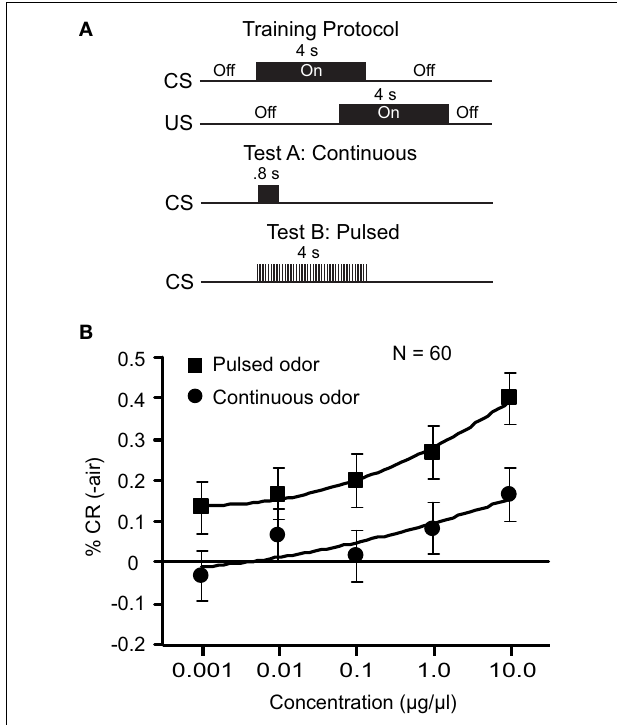
FIGURE 6 | Pulsing odor lowers detection thresholds. (A) Schematic of training and testing protocols for assessing detection thresholds. Animals were trained to respond to an odor presented continuously for 4-s using sucrose as a US. Acquisition of the CR was assessed using both test stimuli: either A on the fi rst and B on the second day or vice versa. Test A was a 0.8-s continuous odor stimulus and Test B a 4-s stimulus pulsed at 20 Hz with a 10:40 ms on:off duty cycle. Stimulus durations and duty cycles adjusted so that the total odor delivered for Test A was identical to Test B. (B) Mean conditioned response as a function of concentration of pulsed stimulation (squares) or continuous stimulation (circles). Error bars indicate standard error. Responses elicited by pulsed or continuous blank stimuli were subtracted from response measures for each concentration. Therefore, the percent response for the lowest concentration for the continuous stimulus is below